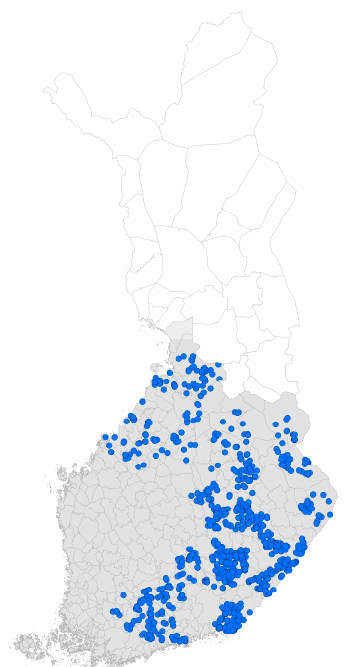
Figure 1. The distribution of harvesting sites ( n = 1831) in the study. The gray color in the map displays the risk zone of the spread of Heterobasidion spp. root rot in Finland [39].